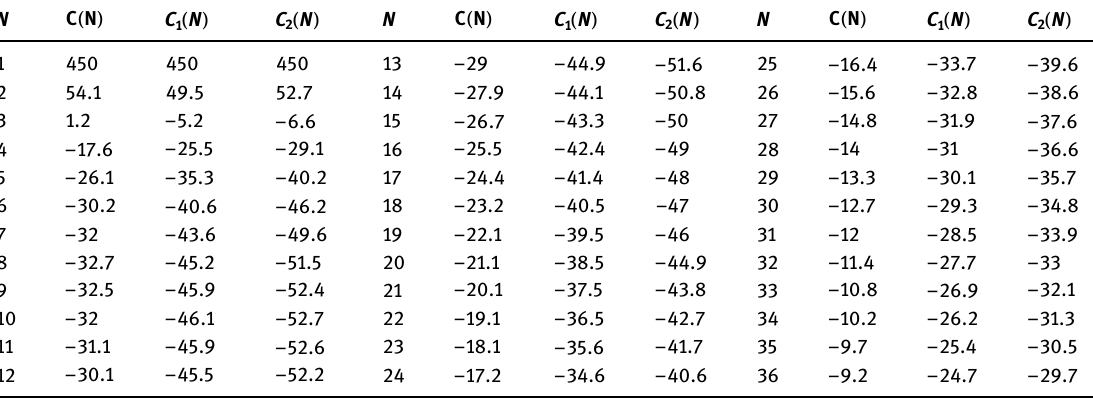
Table 1: The system average cost